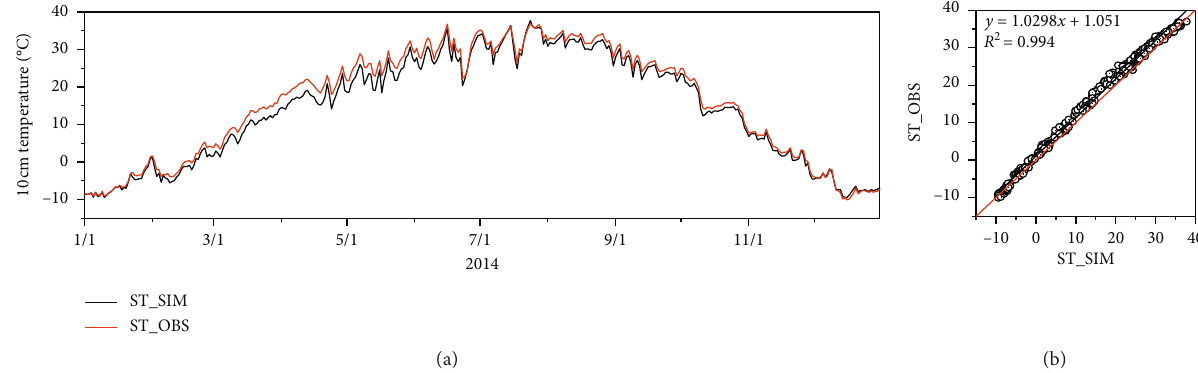
Figure 1: Contrast curve (a) and scatter plot (b) of the simulated (black, via Noah) and observed (red) soil temperature (ST) for soil at a depth of 10cm at the Tazhong station in